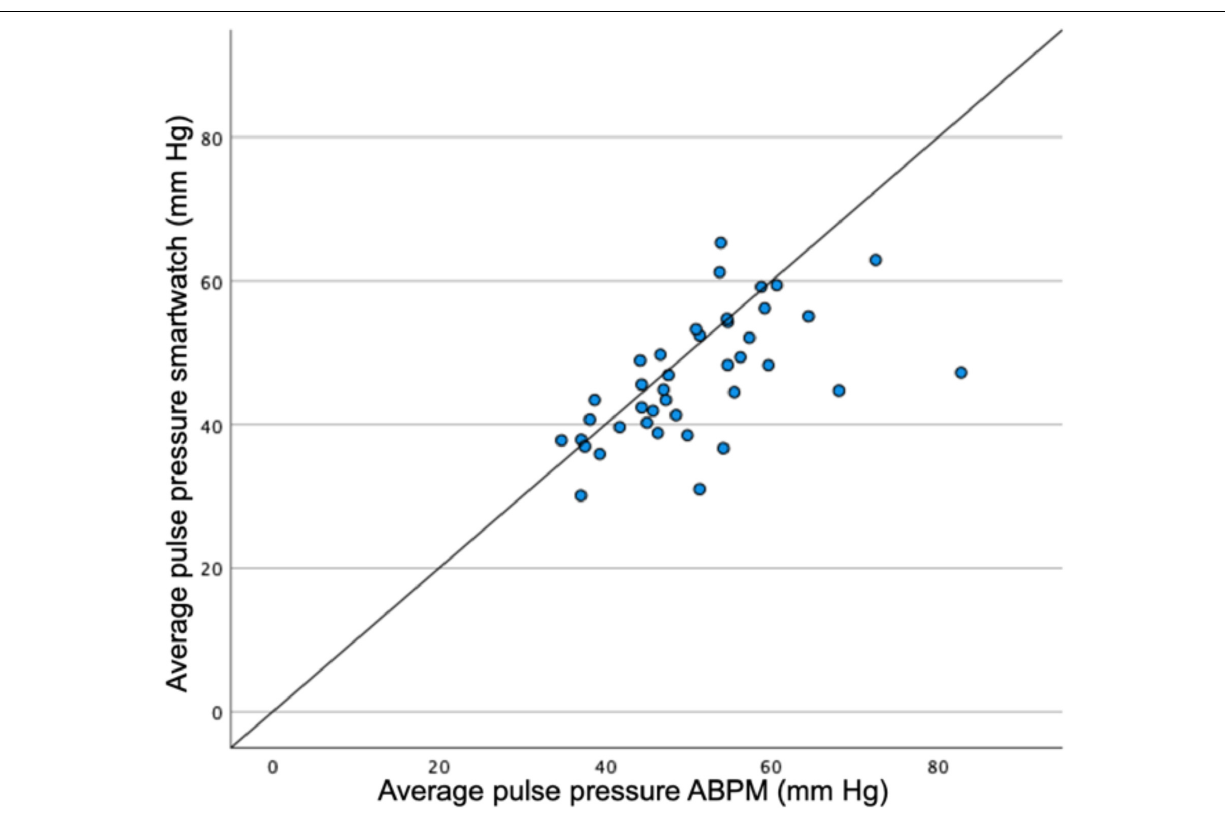
FIGURE 5 | Scatterplot for pulse pressures measured by ABPM vs. smartwatch measurements per patient. ABPM, ambulatory blood pressure